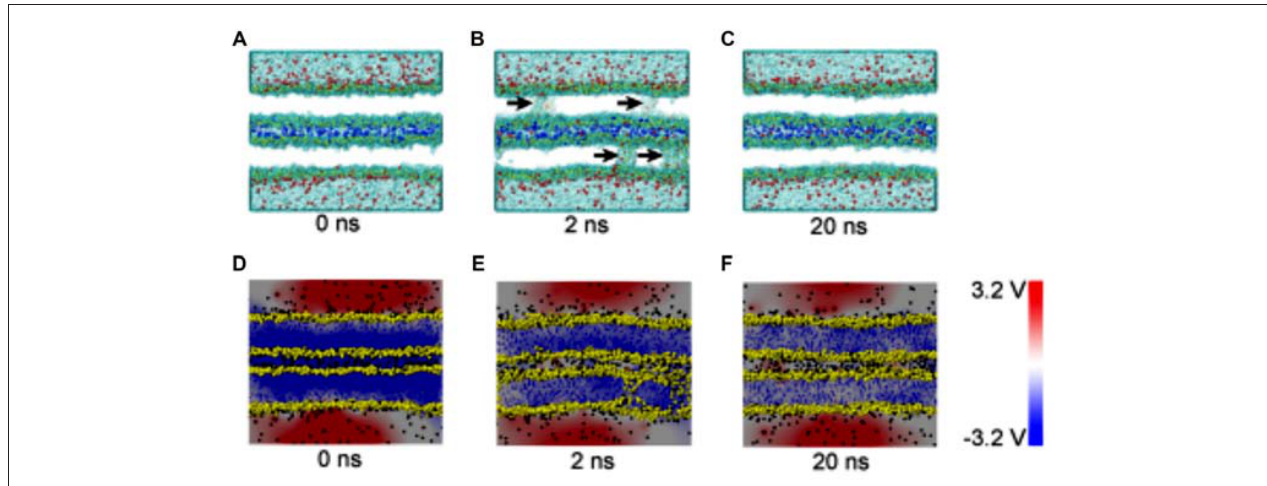
FIGURE 4 | Snapshots and electrical potential distributions during the process of fusion pore (membrane contact-pore formation-membrane healing) through the molecular dynamics (MD) simulations (A–C) : the process of fusion pore formation. (D–F) : electric potential alteration during the process (Bu et al., 2016).